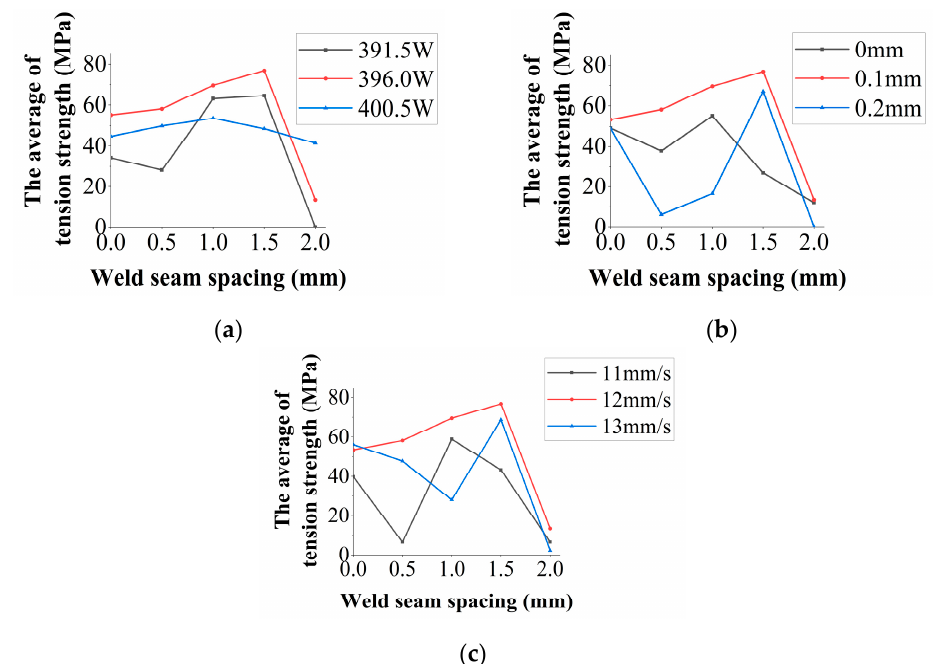
Figure 3. The suitable laser welding parameters are based on a single variable principle. ( a ) Change laser power; ( b ) change weld speed; ( c ) change defocusing distance.